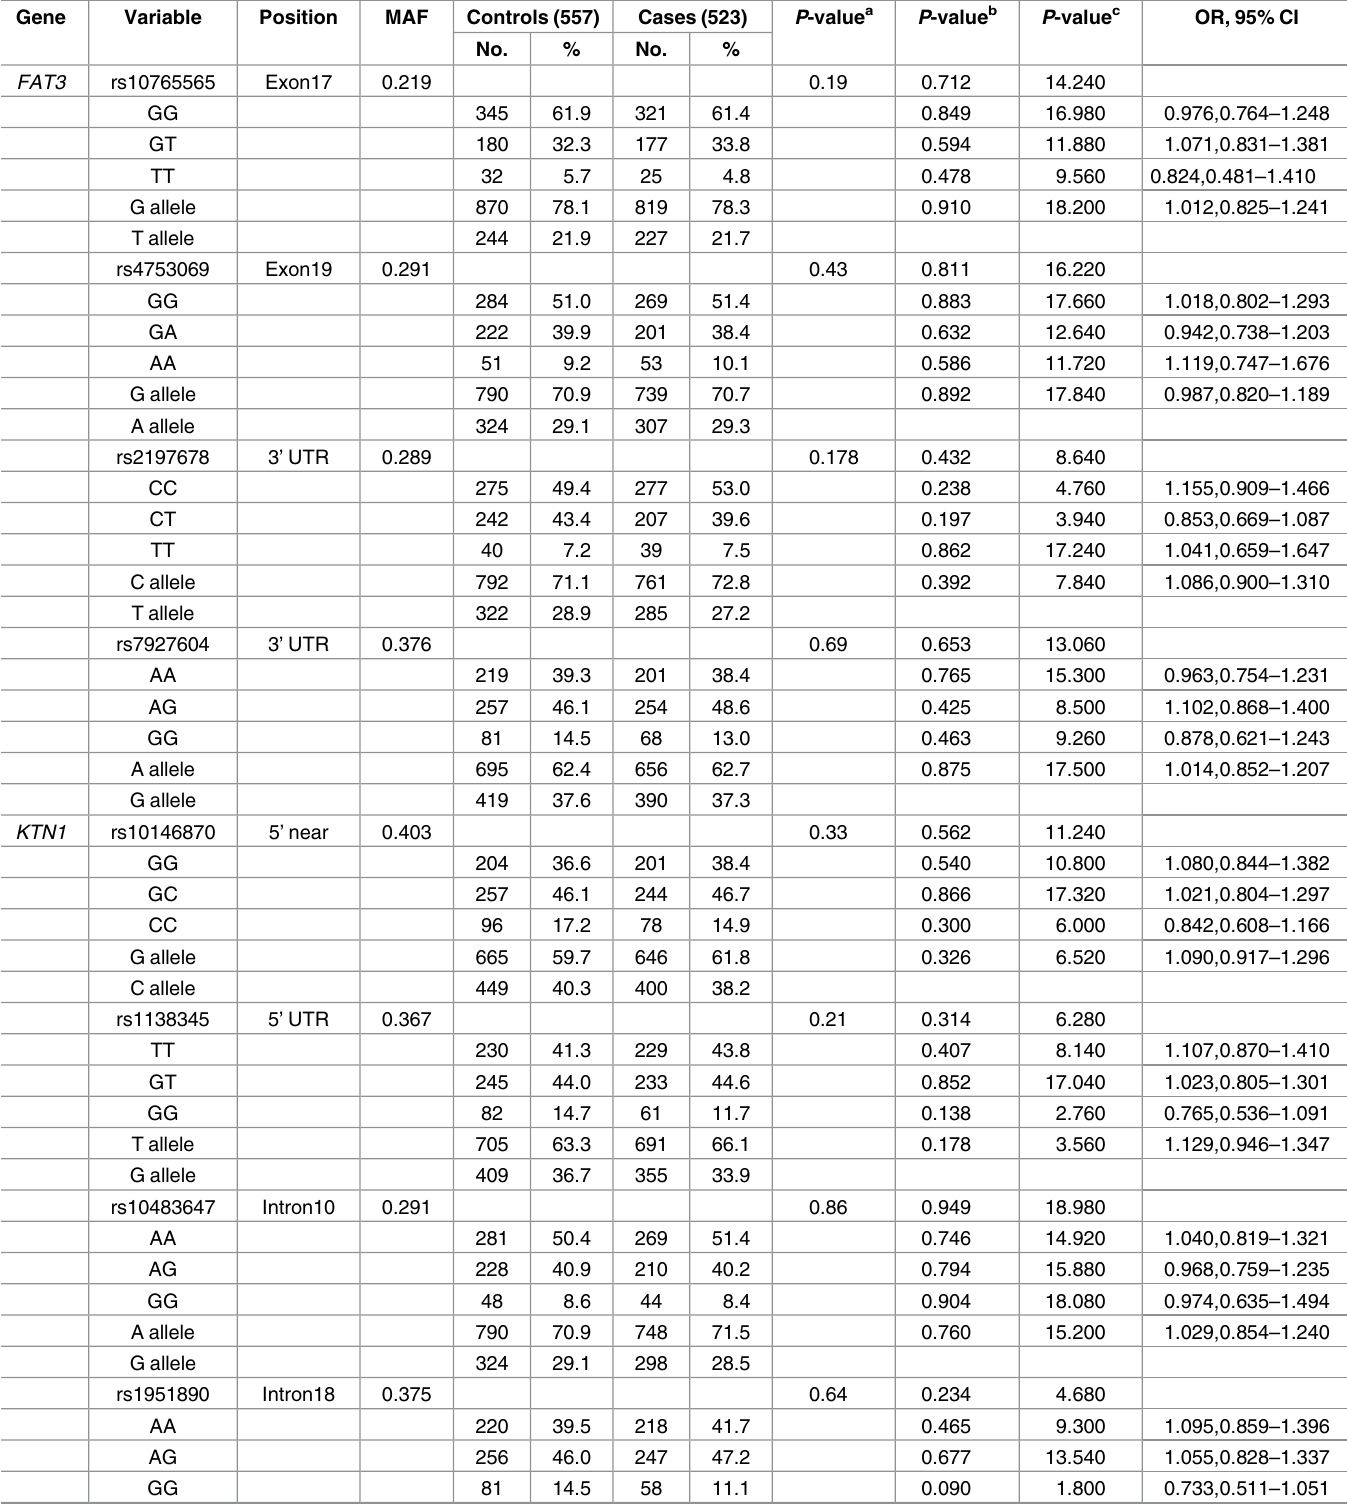
Table 1. Genotypic and allelic frequencies of gene polymorphisms in the control and case group and statistical results. Gene